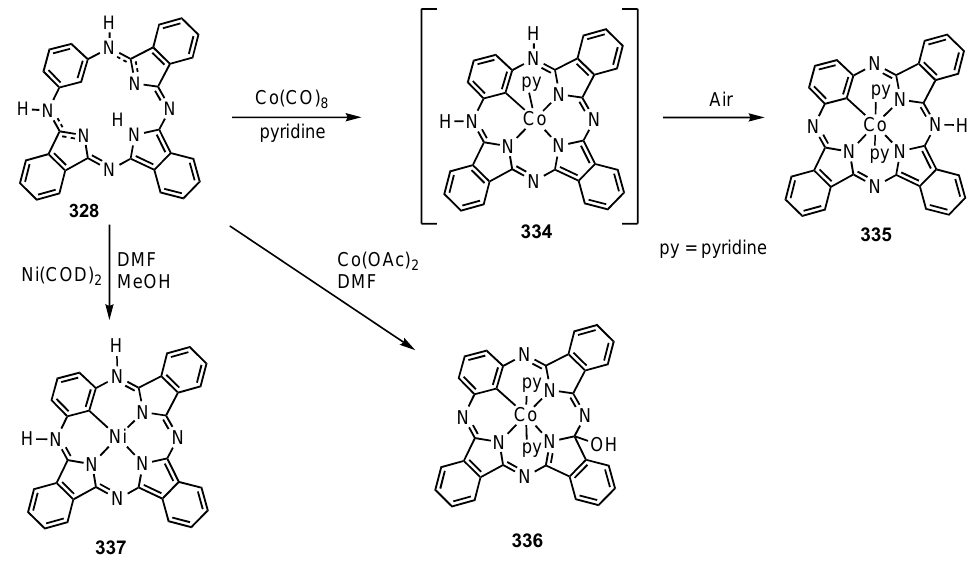
Scheme 54. Organometallic complexes of